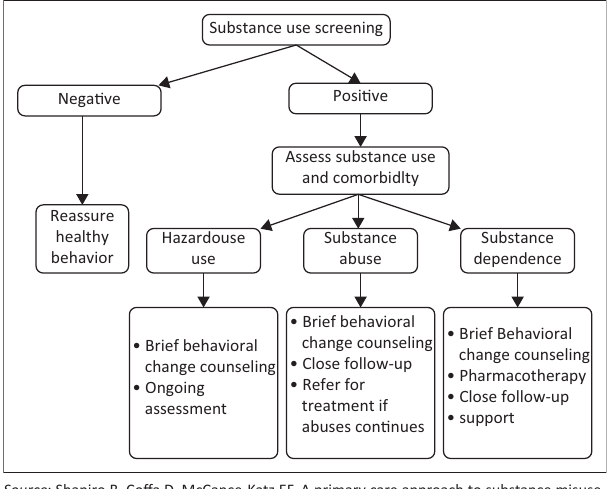
FIGURE 2: The management strategy of substance